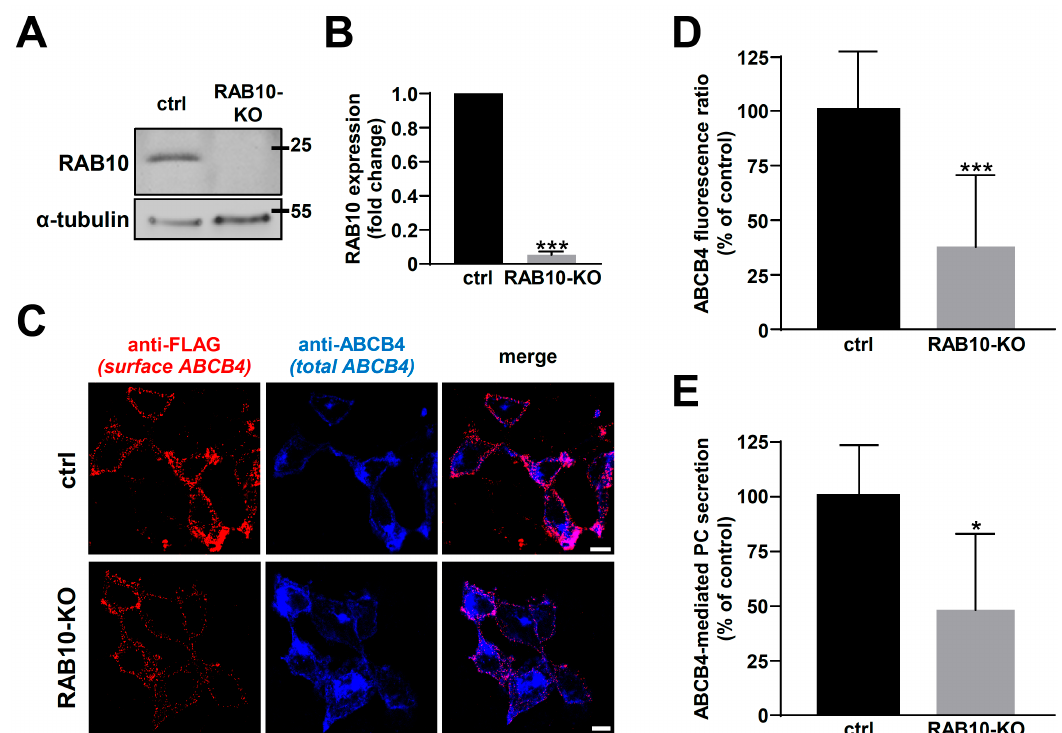
Figure 5. Effect of RAB10 knockdown on ABCB4 localization and function in HEK cells. ( A , B ) RAB10 expression in control (ctrl) and RAB10-KO HEK cells was analyzed (A) and quantified (B) as in Figure 4A,B. (A) is representative of three inde- pendent experiments and (B) represents the means (±SD) of three independent experiments; *** p < 0.005. The presented data were cropped from full immunoblots shown in Supplementary Figure S7. ( C ) HEK cells treated as in (A) were used to analyze ABCB4-FLAG localization at the plasma membrane, as performed in Figure 3B. This panel is representative of three independent experiments. Bars: 10 µm. ( D ) Quantification of (C), as performed in Figure 3C. Means (±SD) are rep- resented; *** p < 0.005. ( E ) Control (ctrl) and RAB10-KO HEK cells were used to measure ABCB4-mediated PC secretion, as performed in Figure 2C. Means (±SD) of three independent experiments are shown; * p < 0.05.